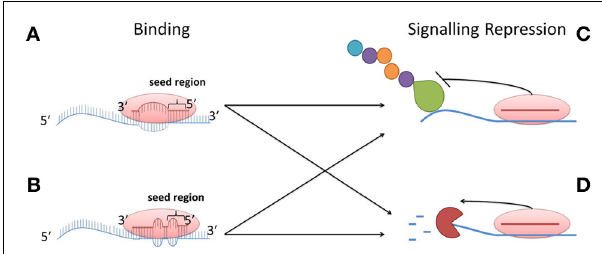
FIGURE 1 | Schematic representation of possible miRNA—mRNA interactions. (A) Perfect Watson-Crick complementary binding. (B) Imperfect binding, with compensatory binding at the 3 (cid:2) end of the mRNA molecule. Once bound to the mRNA molecule, the miRNA can either (C) inhibit protein translation, or (D) induce mRNA